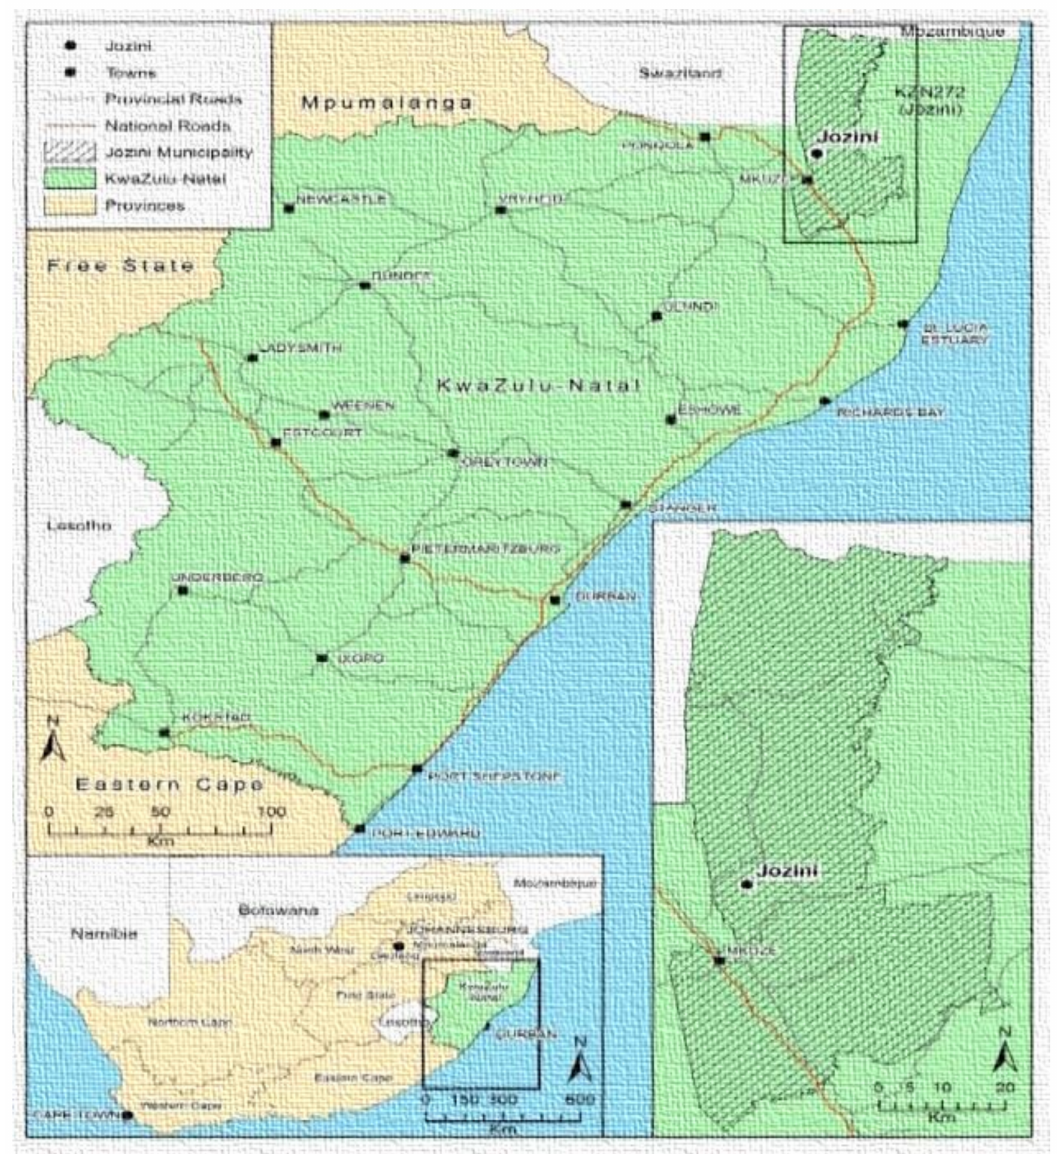
Figure 1. Location of the study